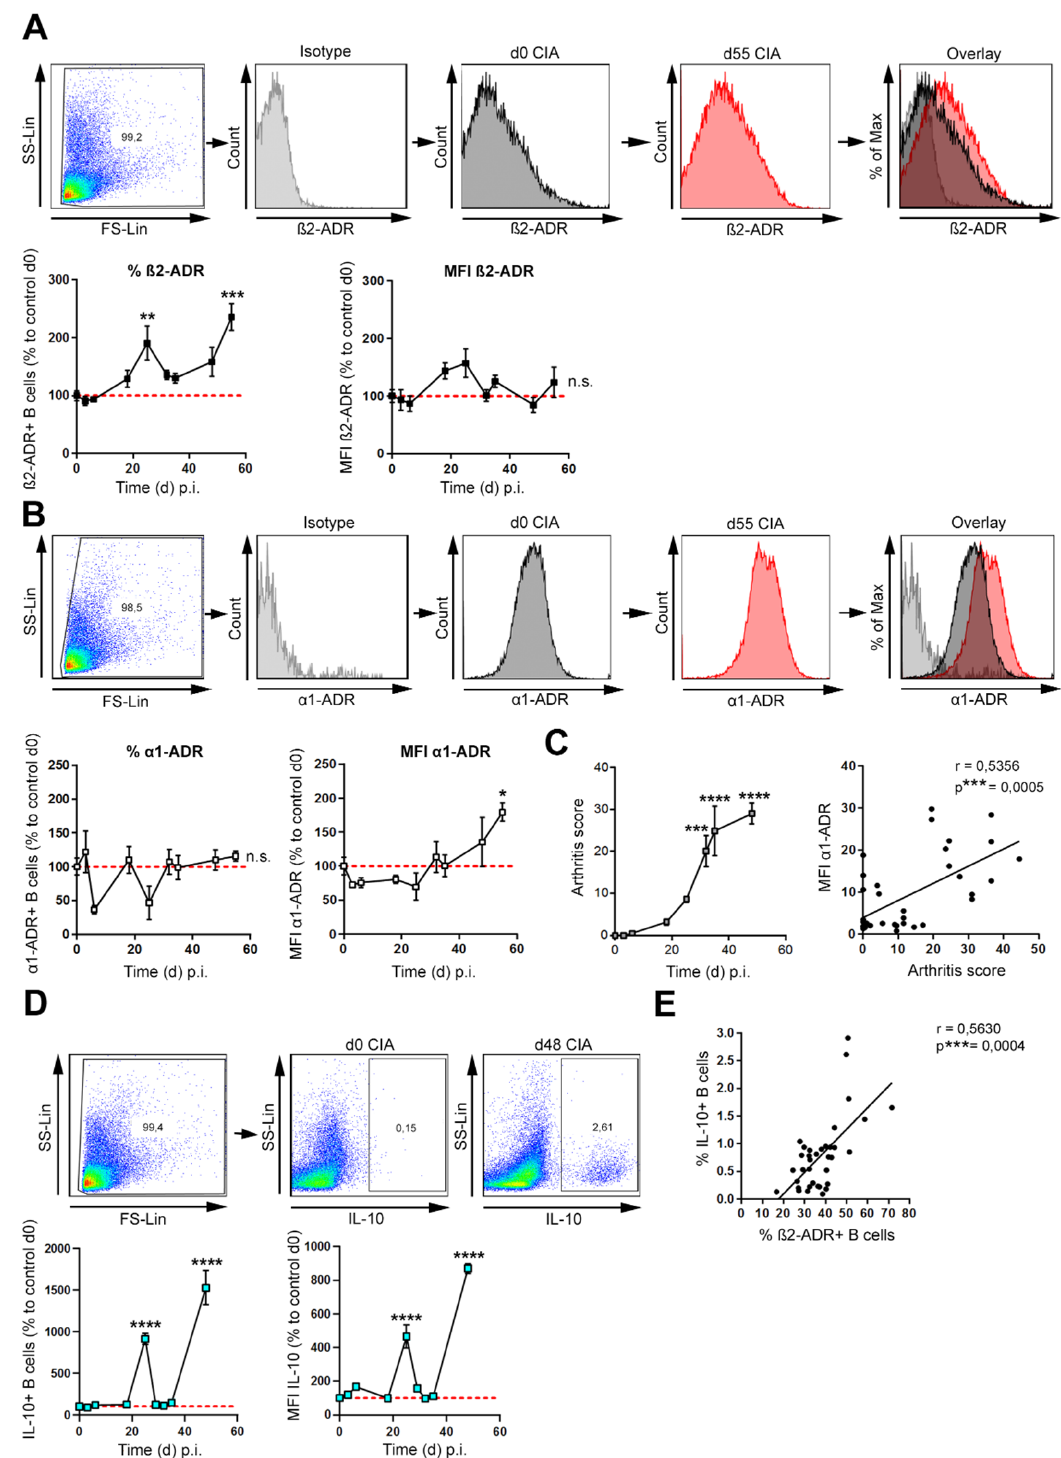
Figure 1. β 2 ‐ ADR positive B cells increase during collagen ‐ induced arthritis and correlate with IL ‐ 10. ( A – E ): DBA/1J mice were immunized with 100 μ L emulsion of collagen type II and complete Freund’s adjuvant. B cells were isolated from the spleen by magnetic ‐ activated cell sorting (MACS) at days (d) 0, 3, 6, 18, 25, 32, 35, 48 and 55 post immunization (p.i.). The frequency and mean fluorescence intensity (MFI) of β 2 ‐ ( A ) and α 1 ‐ ( B ) adrenergic receptors (ADRs) were measured on splenic B cells at the indicated time points ( n = 3–6). ( C ): The arthritis score was monitored and the correlation of α 1 ‐ ADRs and arthritis score was analyzed ( n = 3–6). ( D ): The frequency and mean fluorescence intensity of IL ‐ 10 ‐ expressing B cells was analyzed by flow cytometry ( n = 3–6). The results are shown in comparison to the mean value of d0 values from non ‐ immunized mice (red reference line). The gating strategy is shown ( A , B , D ). ( E ): The correlation of β 2 ‐ ADR and IL ‐ 10 pos ‐ itive B cells was quantified ( n = 3–6). Statistical significance was determined by ordinary one ‐ way analysis of variance (ANOVA) followed by Bonferroni post ‐ hoc test ( A – D ). Continuous variables